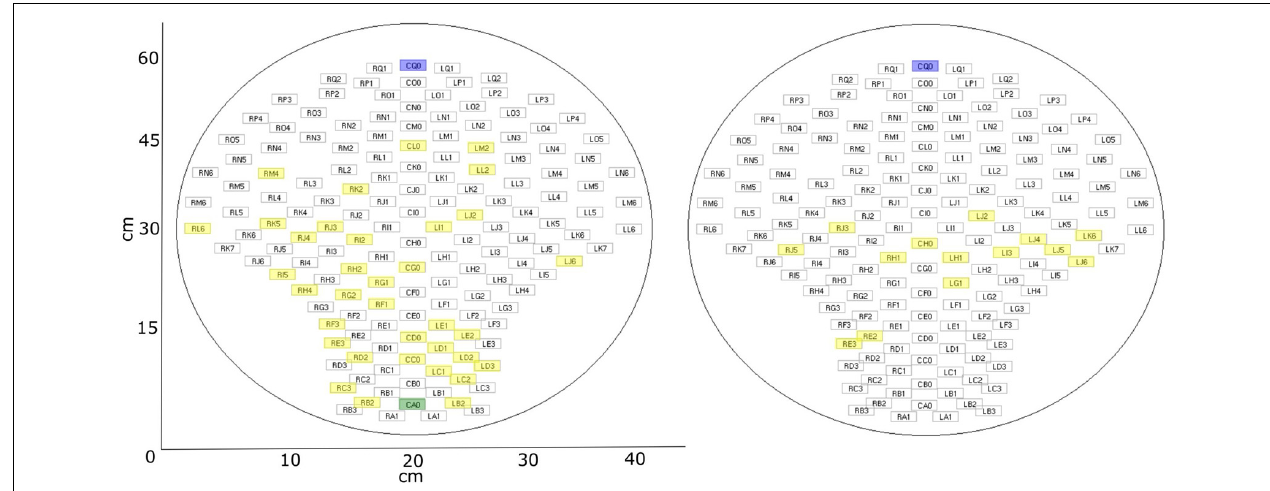
FIGURE 3 | fMEG sensor array with selected channels. Blue: default control channel; green: alternative control channel (if default is closer than 15 cm to brain channel); yellow: selected brain channels. Left: fetal recordings; right: neonatal